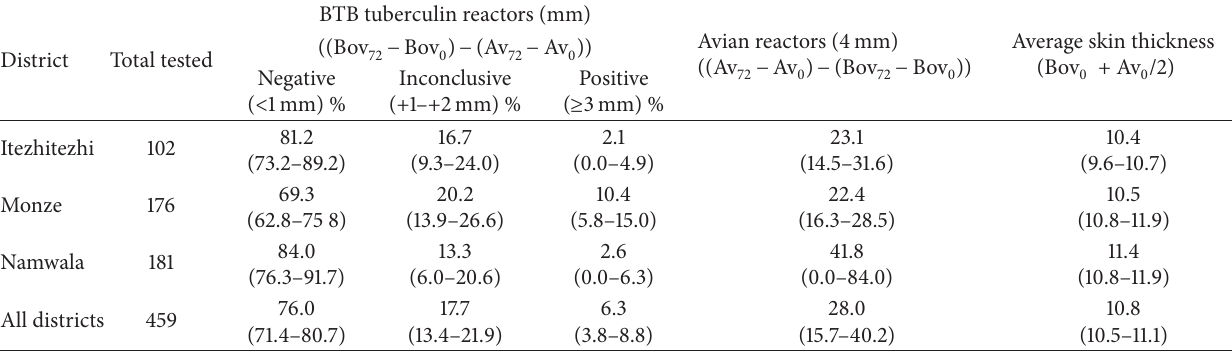
Table 4: Distribution of tuberculosis cattle reactors by district at ≥ 3 mm cutoff (2008).